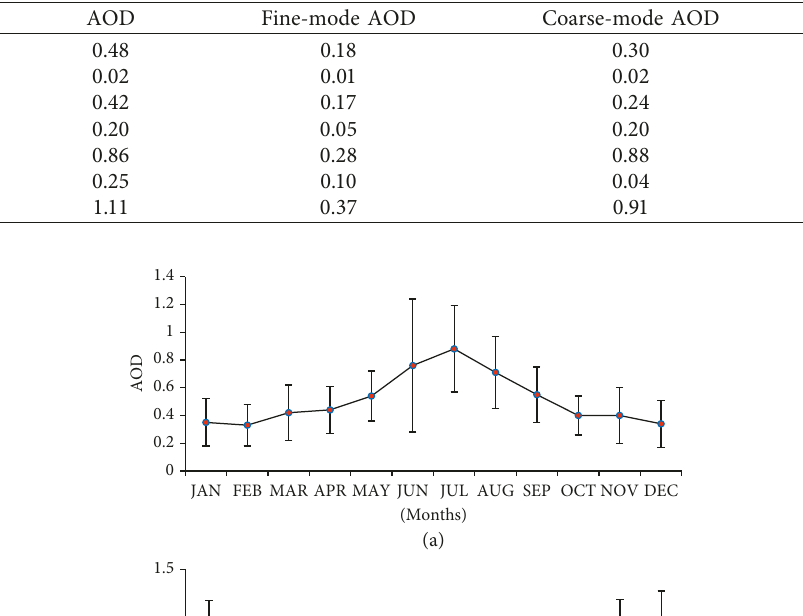
Figure 3: (a) Time series and linear trend of monthly mean AOD over Karachi during September 2006–August 2014. Broken line means no data. (b) All points AOD data at 500nm over Karachi during September 2006–August 2014. Table 1: Descriptive statistics of monthly average AOD, fine-mode AOD, coarse-mode AOD, and fine-mode fraction at 500nm over Karachi during September 2006–August